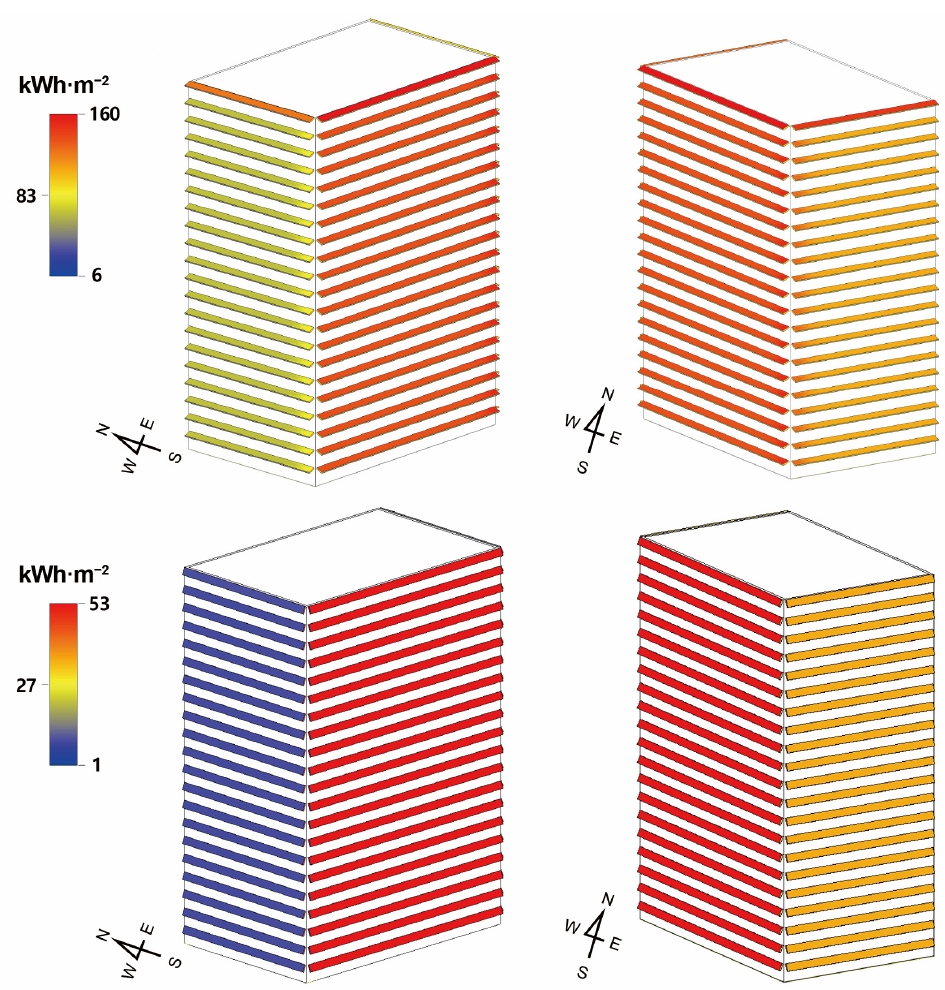
Figure 6. Energy generation simulation of solar panels by optimal tilt angle (24°) in July 2022 ( upper image ) and optimal tilt angle (67°) in December 2022 ( lower image ). Table 5. Energy generation according to the optimal tilt angle ( βо ) from January to December 2022. N.